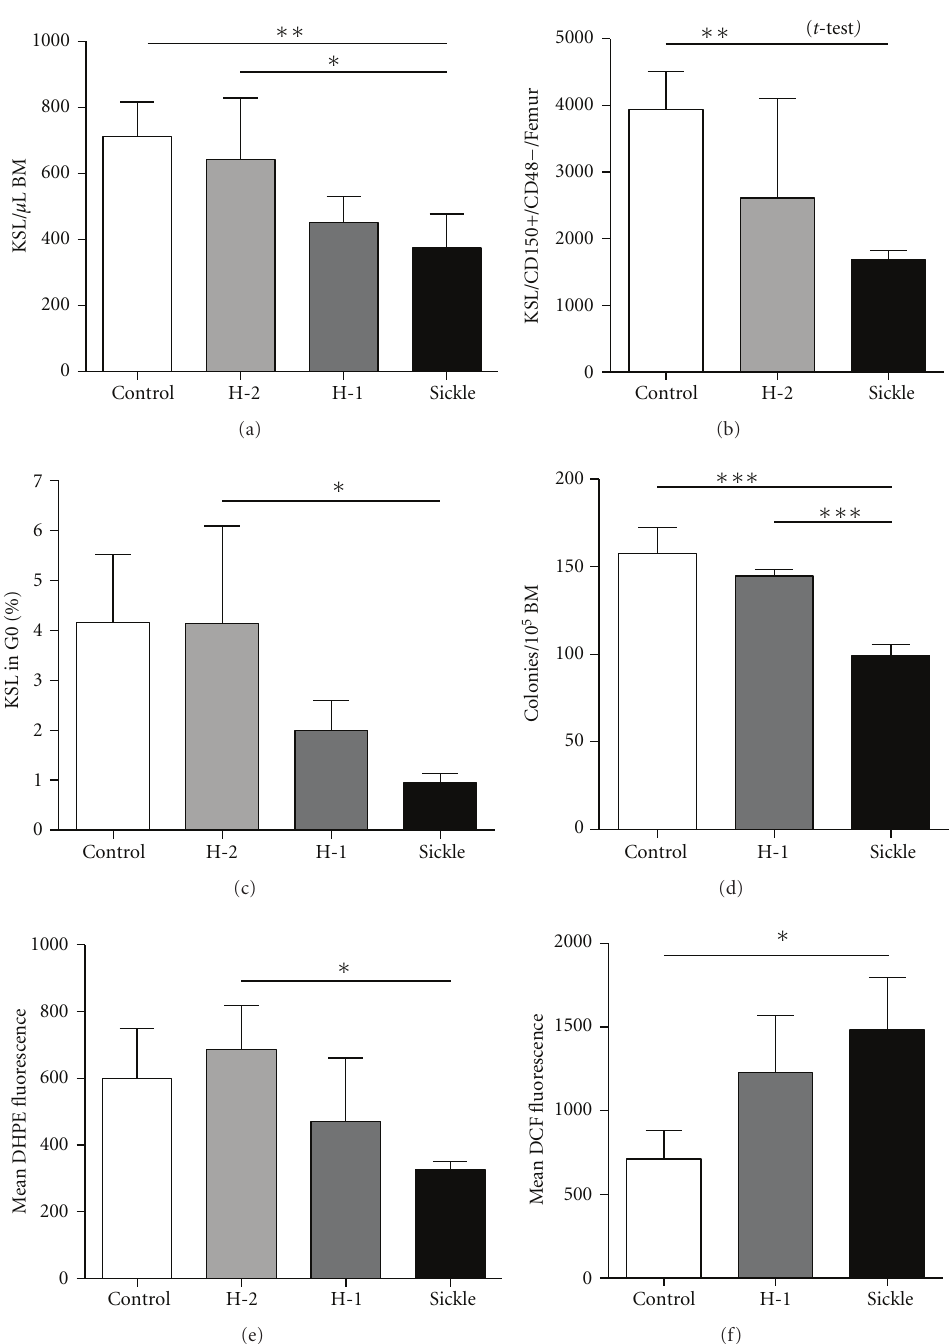
Figure 2: Stem cell number and oxidant state in Berkeley sickle mice. (a) Quantification of KSL progenitor cells in the bone marrow of control, hemizygous, and homozygous sickle mice showing a significant reduction in number in homozygous sickle mice. (b) Further examination of a phenotypically defined HSC population (KSL/CD150+/CD48 − ) also shows a reduction of HSC in sickle BM. (c) HSCs in the stem cell niche are known to be quiescent, and homozygous mice again show significant reduction in KSL cells in the G 0 phase of the cell cycle possibly indicating the mobilization of sickle progenitor cells. (d) The in vitro colony-forming, high proliferative potential assay (HPP) of stem/progenitor cells further indicates a significant reduction in colony-forming cells in homozygous mice. (e) To examine the e ff ect of oxidant stress on hematopoietic progenitors, we measured lipid peroxidation using the fluorescent indicator DHPE. A reduction in fluorescence indicates increased activity of hydroxyl radicals. (f) Further quantification of reactive oxygen species was shown in sickle mice by the increased production of DCF (all graphs are presented as mean ± SD, ∗ P < 0 . 05, ∗∗ P < 0 . 01, ∗∗∗ P < 0 .